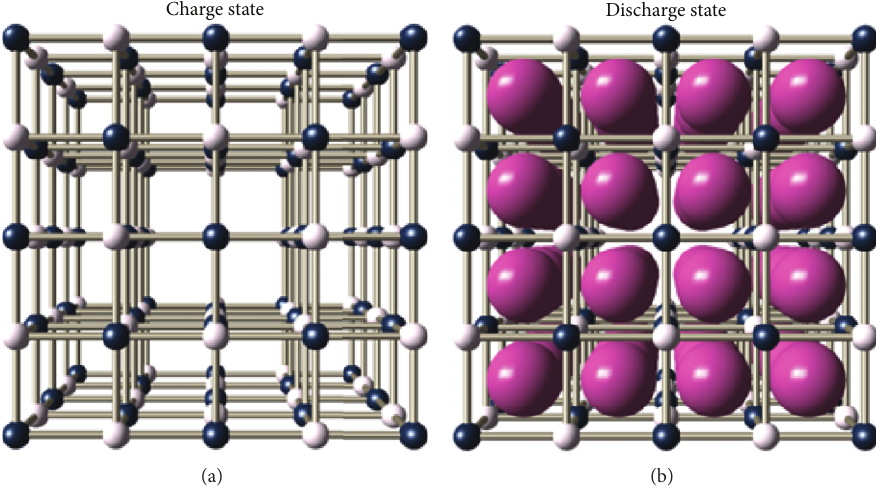
Figure1:SchematicstructuresofPBA, A M [Fe(CN) 6 ] z H 2 O( A and M arealkalimetalandtransitionmetal,resp.)incharge(a)anddischarge x y (b) states. Transition metal and iron (small spheres) are alternatively bridged by the cyano groups (sticks). Big spheres represent the guest alkali cations. Water molecules are omitted for simplicity.